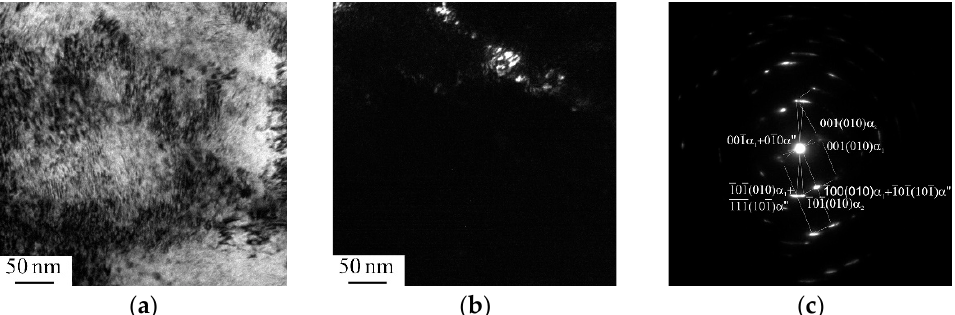
Figure 4. TEM bright- ( a ) and dark-field ( b ) images and associated selected area electron diffraction (SAED) pattern ( c ) of the microstructure of the uppermost surface layer of the CP-Ti sample after the UIT processing. TEM dark-field image was obtained with the 01(cid:3364)0(101(cid:3364)) α ”-Ti reflection.